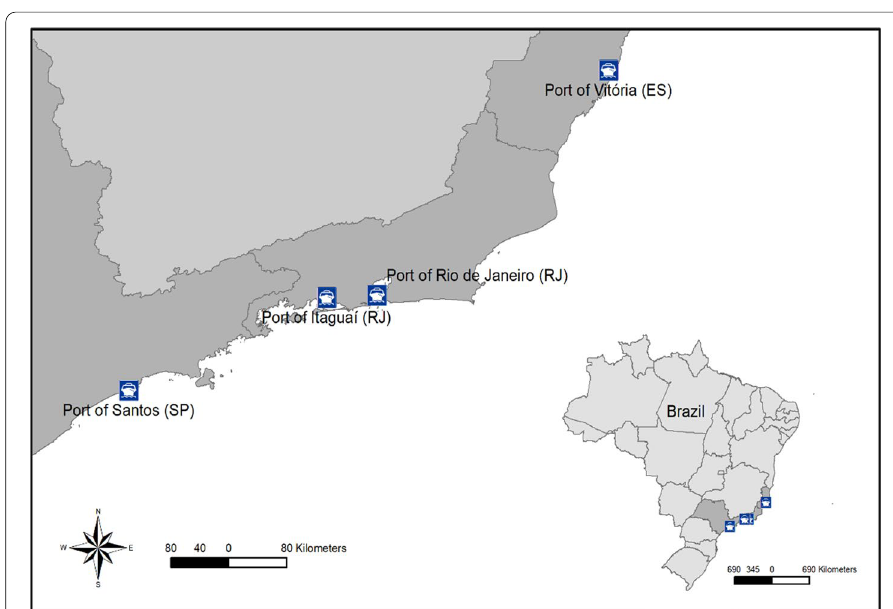
Fig. 1 Ports analysed in the southeast region of Brazil